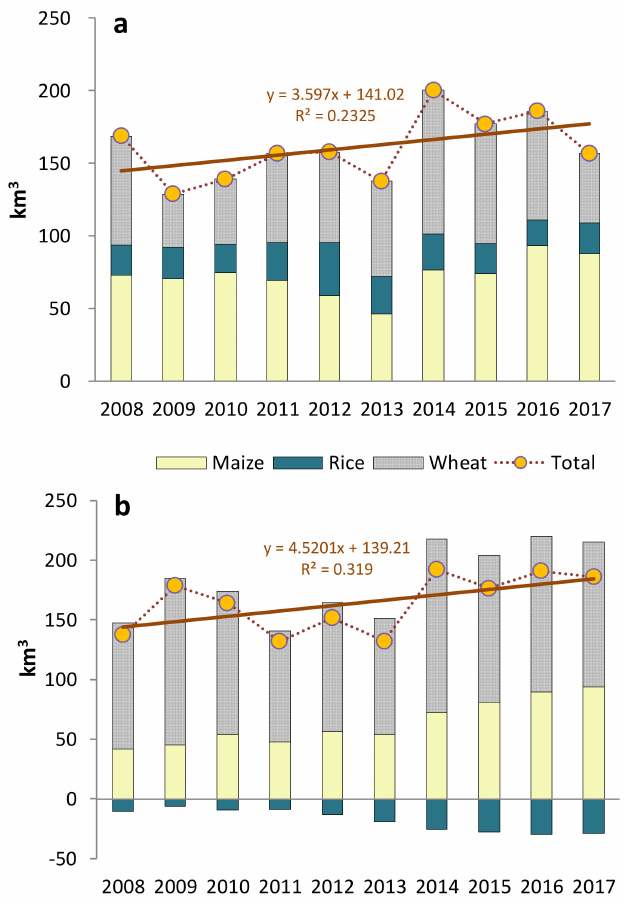
Figure 2. Net savings of ( a ) global virtual water and ( b ) global virtual scarce water in the international trade of maize, rice, and wheat from 2008 to